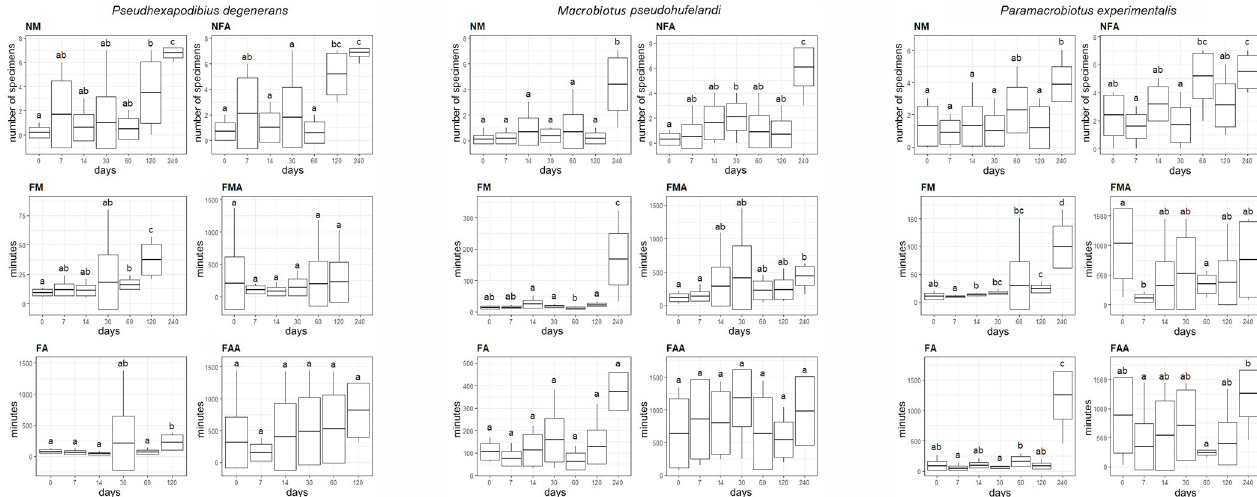
Fig 3. Differences in the number of nonmoving (NM) and not fully active (NFA) individuals, timing of the first movement of any individual (FM) and all moving individuals (FMA), full activity of any individual (FA) and full activity of all active individuals (FAA) between particular treatments (horiziontal axis—days in anhydrobiosis) in populations of three tardigrade species: Pseudhexapodibius degenerans , Macrobiotus pseudokufelandi , Pararamacrobiotus experimentalis . Letters above the boxes (a, b, c, d) denote lack of significant (p < 0.05) differences between groups marked with the same letter.